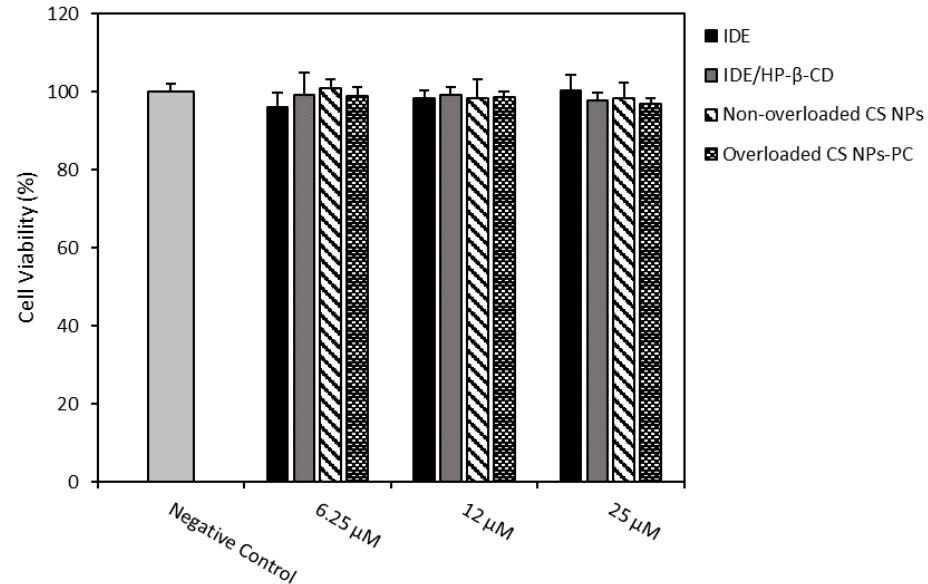
Figure 5. Effects on U373 cell viability of 24 h treatment with 6.25, 12, and 25 µM of IDE, IDE/HP- β -CD, non-overloaded CS NPs, and overloaded CS NPs-PC. Cell viability was measured using the MTT test. Results are presented as the means of three different experiments (six replicates for each point) ± standard deviation. No significant reduction in cell viability (%) was reported in the treated